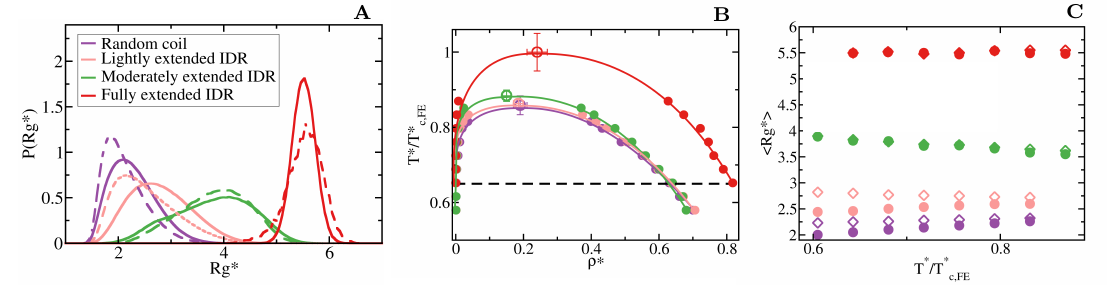
Figure 3. Conformational landscape and phase diagram of the different 20-bead IDRs. ( A ) Probability histograms of the radius of gyration of the different IDRs at T ˚ “ 0.65 T ˚ . T ˚ refers to the critical c , FE c , FE temperature of the fully extended IDR, T ˚ = 2.76, which is the highest critical temperature of the four c , FE different IDRs. Results for the fully flexible random coil ( K ˚ = 0) are depicted in purple, while those θ ones for the lightly ( K ˚ = 1), moderately ( K ˚ = 3) and fully extended ( K ˚ = 20) IDRs in pink, green and θ θ θ red, respectively. Solid lines represent the radius of gyration distribution for proteins that form part of the condensed liquid phase, whereas dashed lines account for the radius of gyration distribution of proteins belonging to the diluted liquid phase. ( B ) Liquid-liquid coexistence lines in the T ˚ ´ ρ ˚ plane for the fully flexible random coil (purple), lightly extended (pink), moderately extended (green) and fully extended (red) IDRs. The temperature is normalized by the critical temperature of the fully extended IDR, T ˚ . Filled circles account for the coexisting densities computed via DC simulations c , FE and empty ones for the estimation of the critical points using Equations (4) and (5). The horizontal black dashed line represents the temperature at which the radius of gyration probability histograms in panel A were evaluated. ( C ) Mean value of the radius of gyration ( ă R ˚ g ą ) as a function of the renormalized temperature, T ˚ { T ˚ , for the previously shown IDRs. The same colour code as in panel c , FE A and B applies here. The values of R ˚ g in the condensed phase along the coexisting densities are depicted by empty diamonds whereas filled circles represent the same but for IDRs in the protein-poor liquid